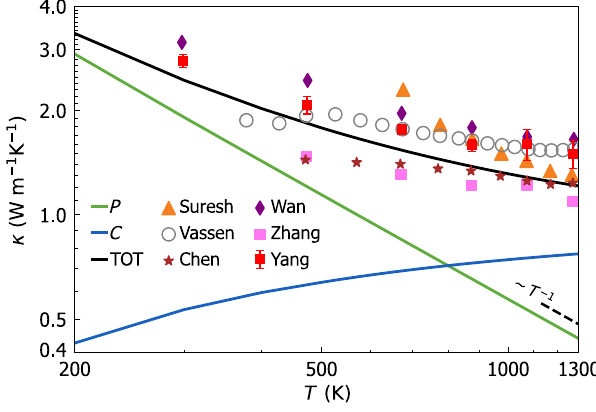
FIG. 3. Bulk thermal conductivity of La 2 Zr 2 O 7 . Scatter points represent measurements from Suresh et al. [106], Vassen et al. [107], Chen et al. [108], Wan et al. [109], Zhang et al. [114], and Yang et al. [110] (the experiment which best represents the bulk crystal studied here is that from Yang et al. ; see text). Green, Peierls ’ s LBTE conductivity ( κ P ), which displays the universal T − 1 asymptotics (dashed line). Blue, coherences ’ conductivity ( κ C ). Black, total conductivity from Eq. (47): κ report the single independent component of the diagonal and isotropic conductivity